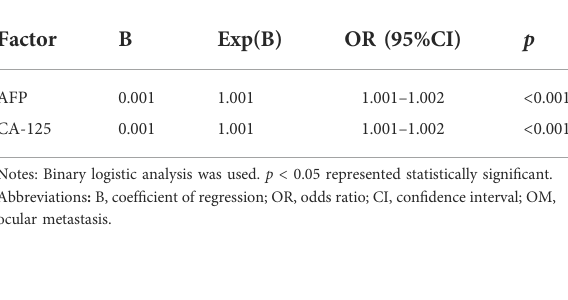
TABLE 3 Independent risk factors of OM in patients with primary liver